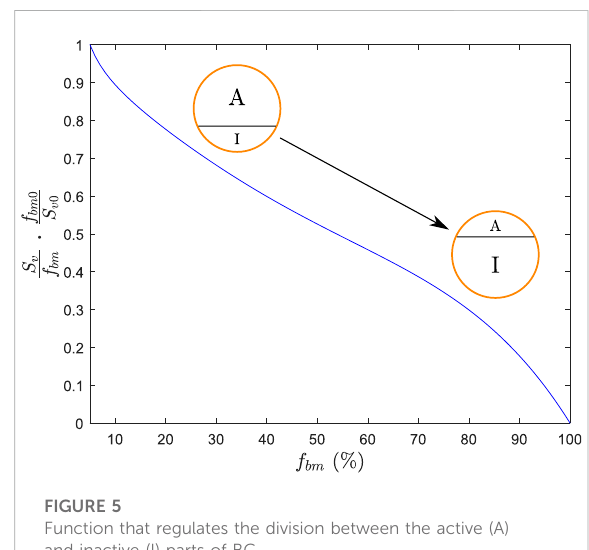
FIGURE 5 Function that regulates the division between the active (A) and inactive (I) parts of